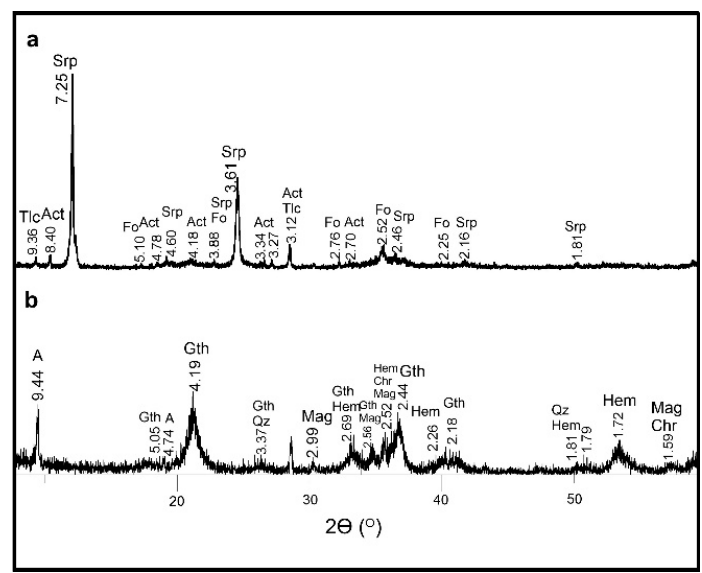
Figure 5. XRPD patterns of samples showing the ( a ) occurrence of serpentine, actinolite, talc and relict olivine, and ( b ) presence of asbolane with goethite, hematite, magnetite, chromite, and quartz. Srp—